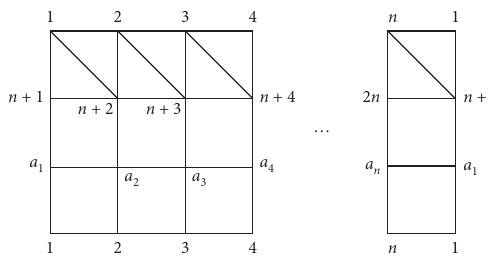
Figure 11: DSEM of type- [ 3 3 , 4 2 : 4 4 ]